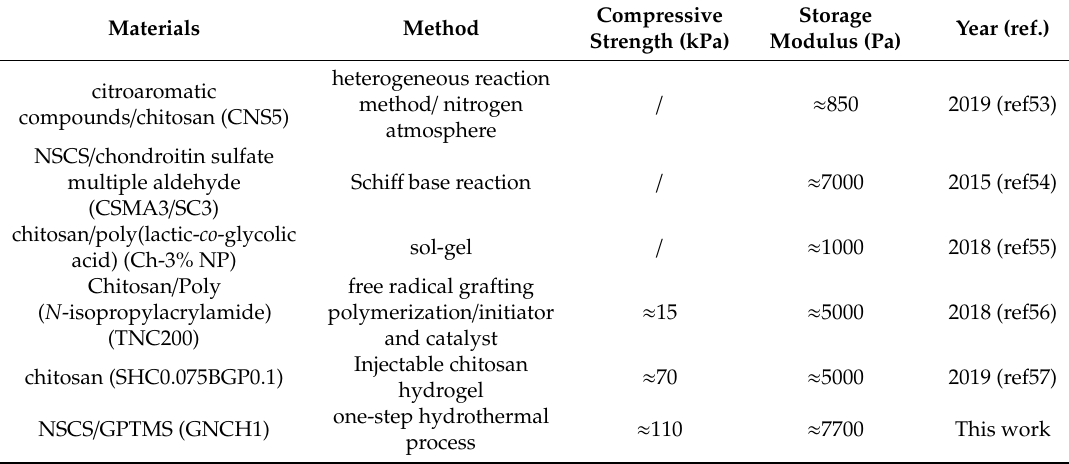
Figure 9. ( a ) Storage modulus (G’, 1% strain) and ( b ) loss modulus (G”, 1% strain) as a function of frequency (Hz) at 25 ◦ C. ( c ) Compressive stress-strain curves at 60% strain for GNCH with various cross-linker contents. Table 2. The storage modulus of CNS5 [53], the storage modulus of CSMA3 / SC3 [54], the storage modulus of Ch-3% NP [55], the Compressive strength and storage modulus of TNC200 (25 ◦ C) [56], the Compressive strength and storage modulus of SHC0.075BGP0.1 [57], the Compressive strength and storage modulus of